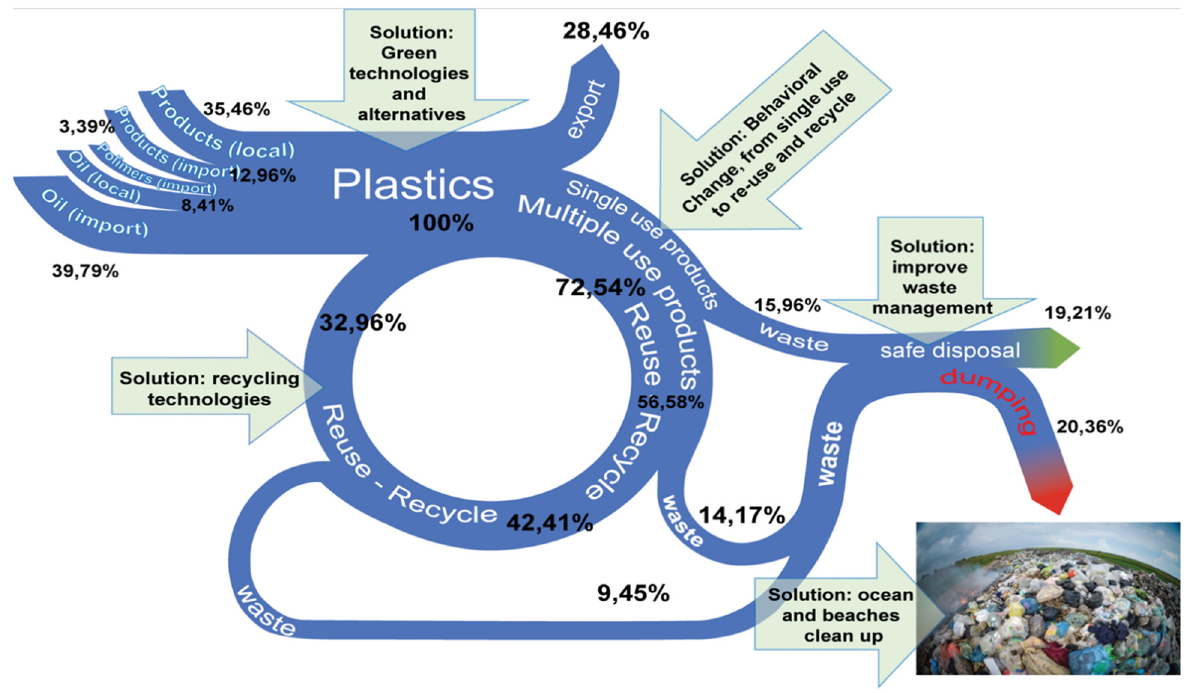
Figure 4: Plastic cycle 2018 with subconstruct toward circular economy